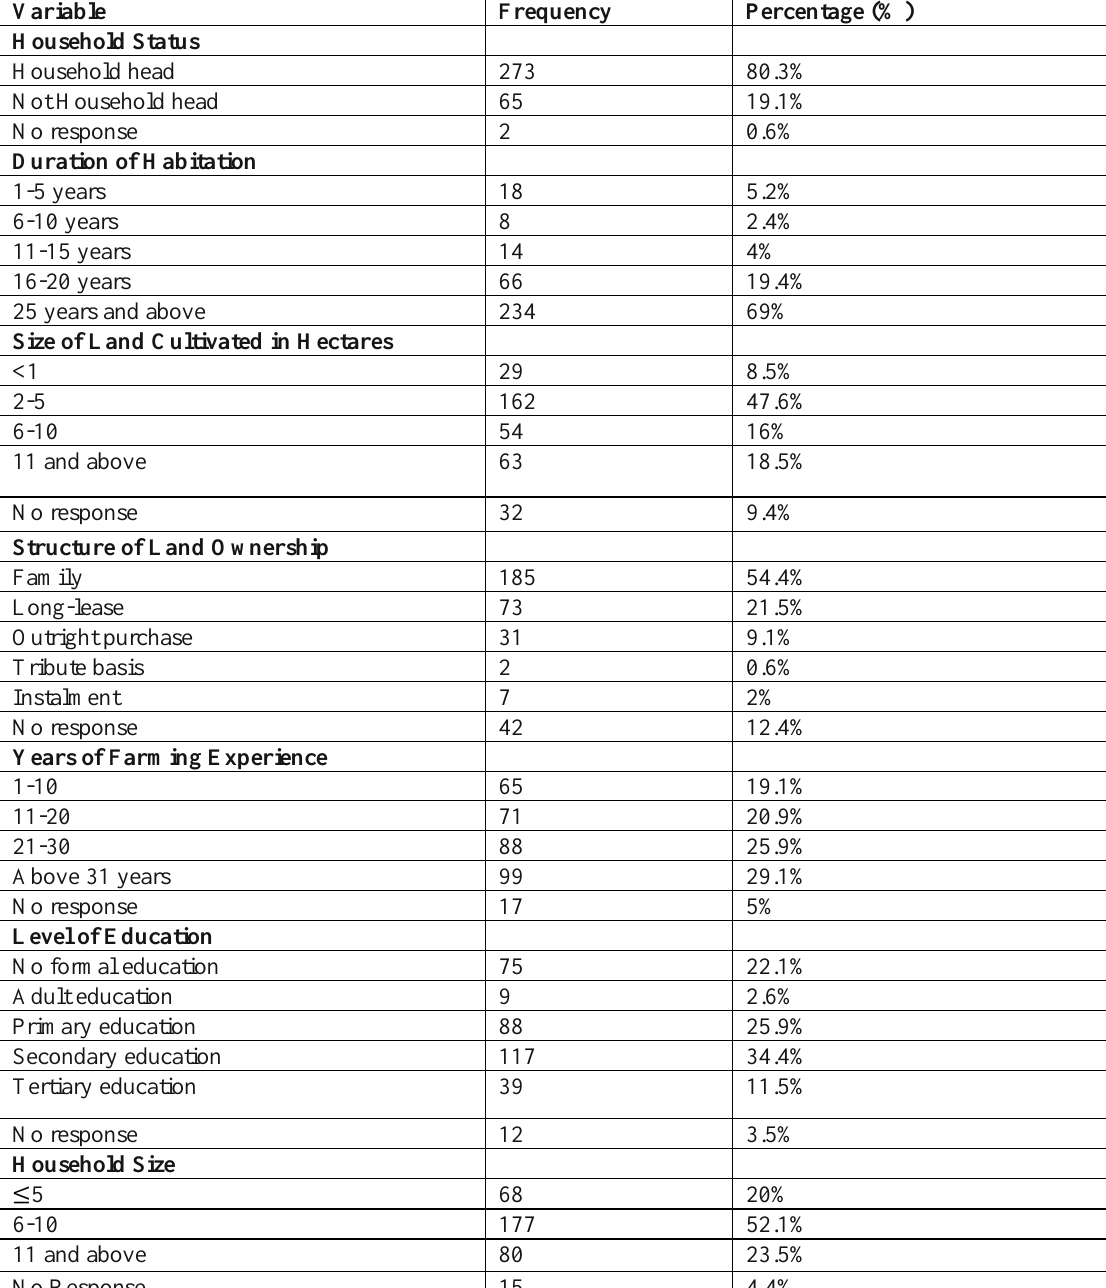
Table 2: Distribution of Respondents by their